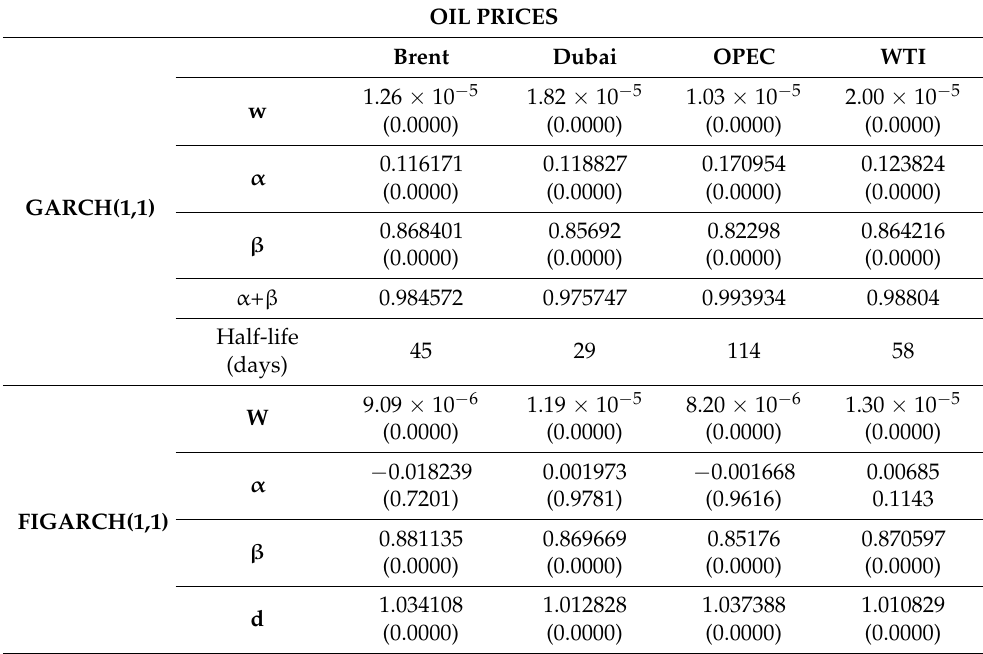
Table 12. Oil Benchmarks Volatility